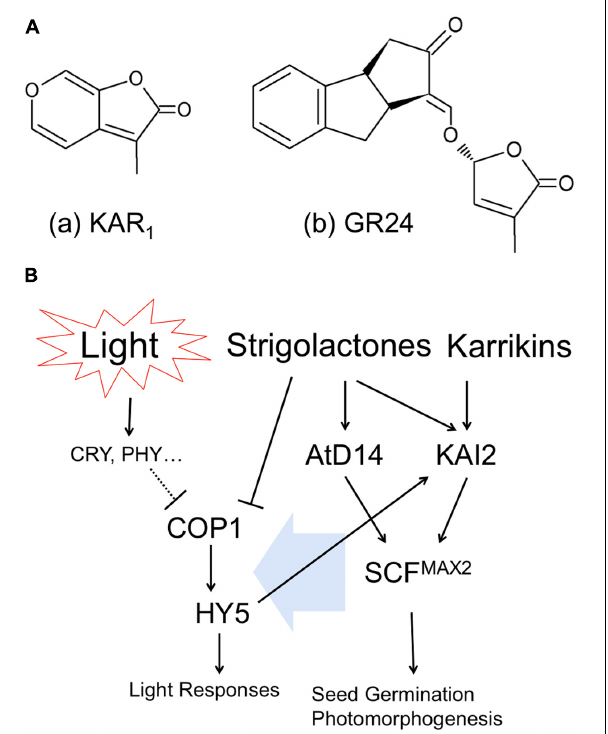
FIGURE 1 | Cross talk between butenolide plant hormones and light signaling pathways. (A) Chemical structures of (a) Karrikin1, KAR 1 and (b) Strigolactone analog, GR24. (B) Interaction of hormonal and light signaling